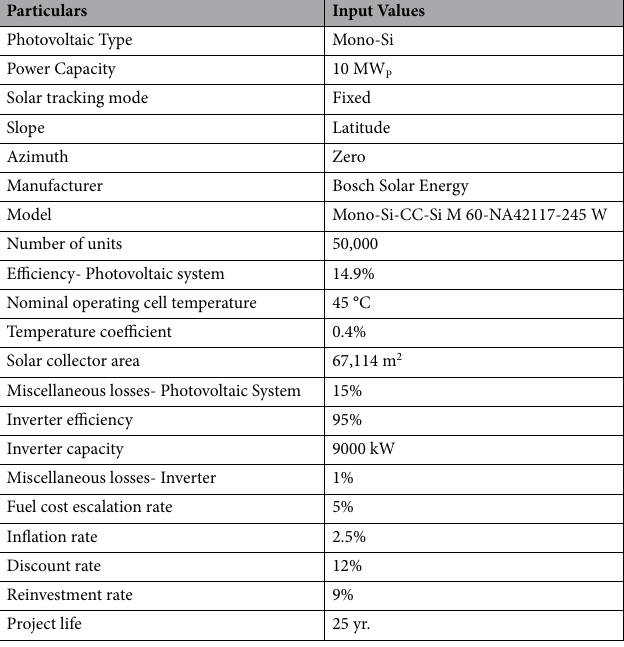
Table 4. Simulation input